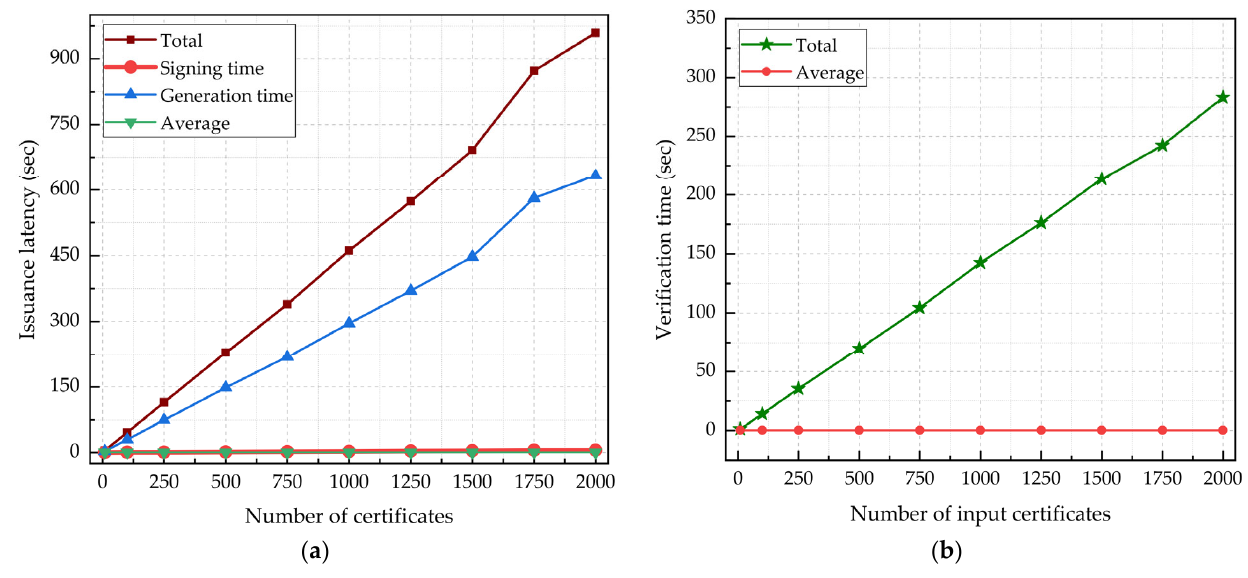
Figure 9. E ‐ portfolio certificate signing, generation, and verification time: ( a ) e ‐ certificate issuance transaction latency measurements with variable input transaction rates; ( b ) e ‐ certificate verification time measurements with variable input certificate numbers.